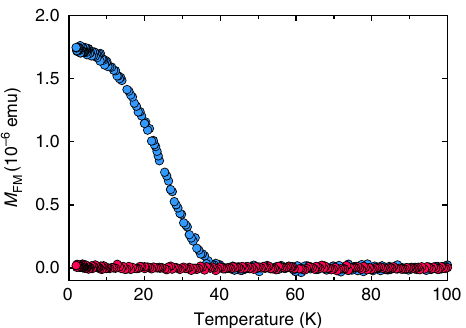
Fig. 6 2D magnetism of GdSi 2 polymorphs. Temperature dependence of magnetic moment in a magnetic fi eld of 50 Oe: tetragonal GdSi 2 of 2 unit cell thickness (red) as compared with 2 ML silicene-based GdSi